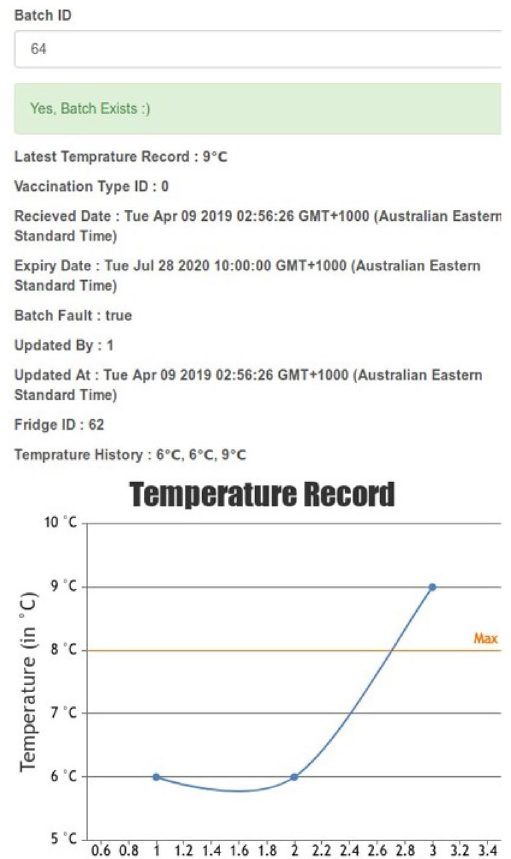
Figure 7. Temperature record check using batch id.